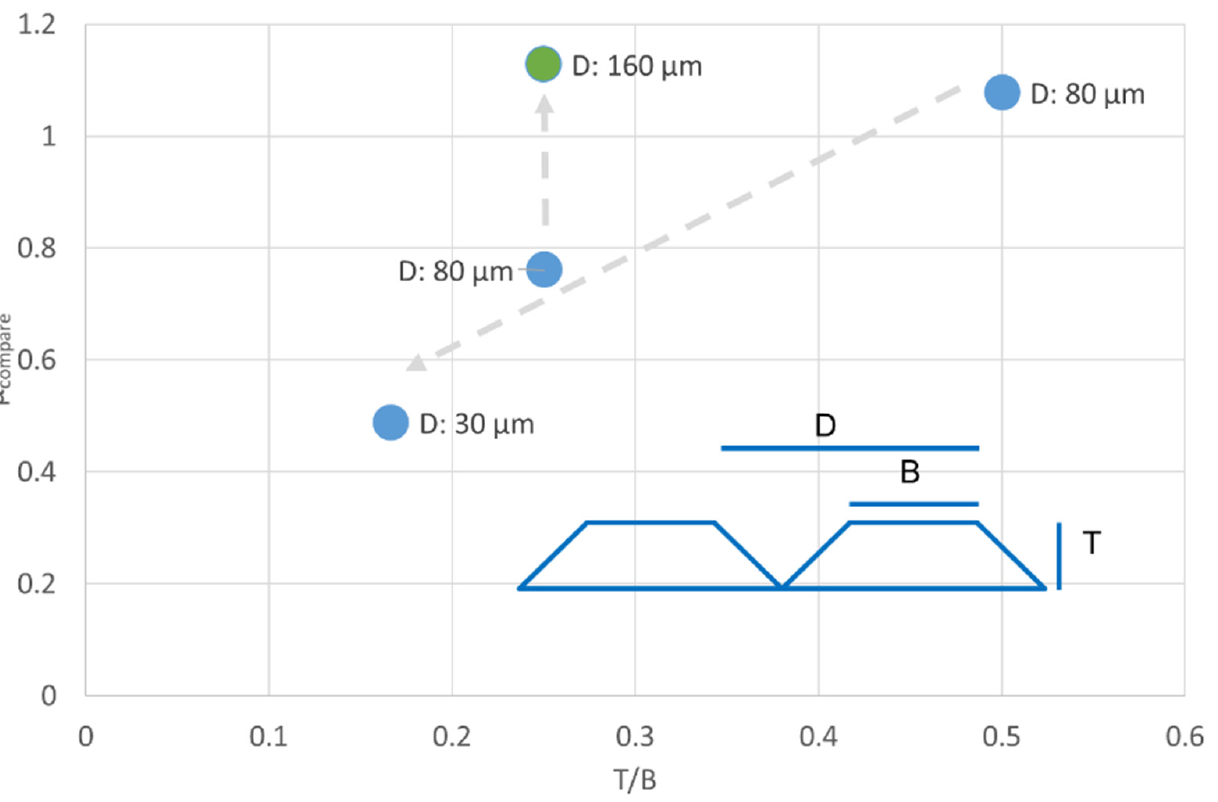
Figure 15. Linear groove structures were tested, which were created in the LSR surface with different defined parameters (D, B and T) by laser structuring of molds.